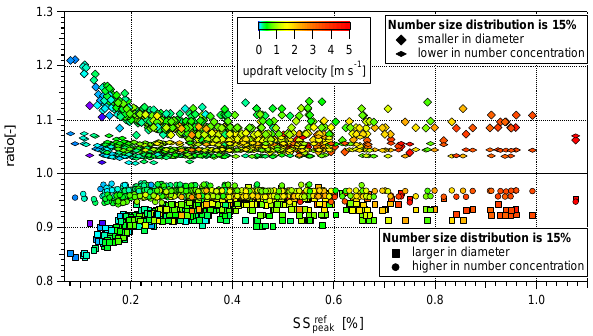
Figure 7. Ratio of effective peak supersaturation values using ei- Figure 6. Ratio SS peak : SS ref using: 15% higher (circles) and ther a hygroscopicity value of κ = 0 . 1 or 0.3 to the effective peak peak lower (flat diamonds) particle number concentration compared to supersaturation when using the median hygroscopicity parameter the measured one, and 15% larger (squares) and smaller (diamonds) measured at the Jungfraujoch of κ = 0 . 2. The points of the data sets particles compared to the measured size distribution. All symbols are colour coded to show the modelled updraft are colour coded to show the modelled updraft velocities.